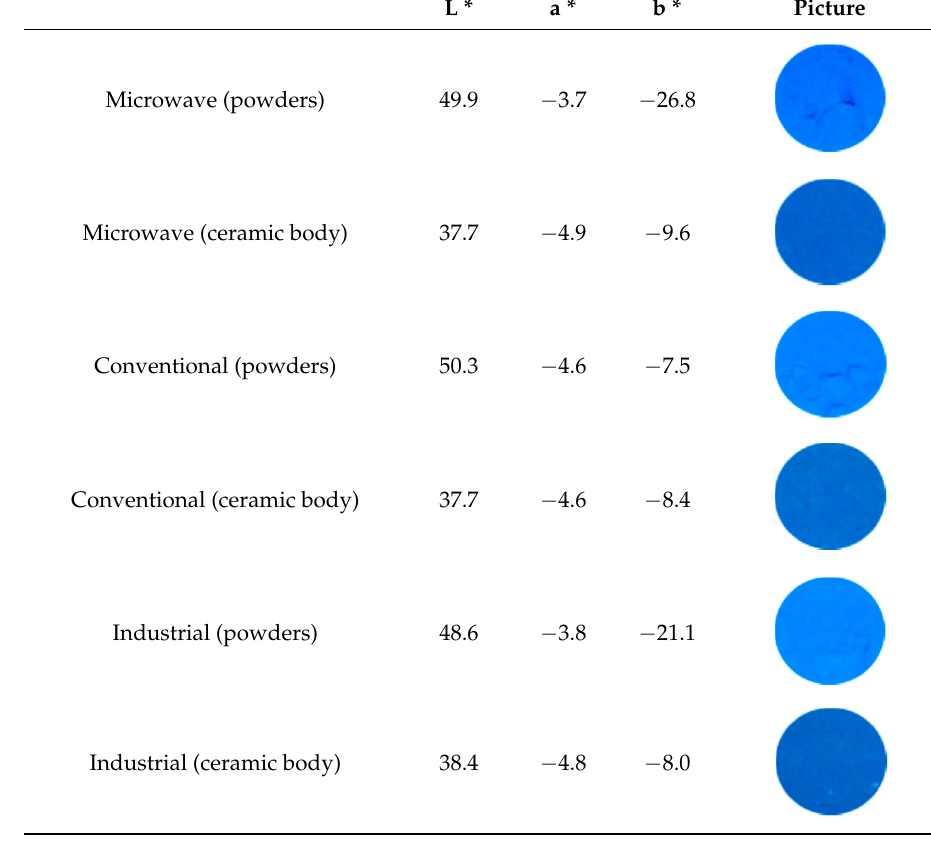
Table 2. L *, a *, b * parameters of the pigments obtained by calcination at 1200 °C and after firing at 1150 °C, dispersed inside a ceramic body.